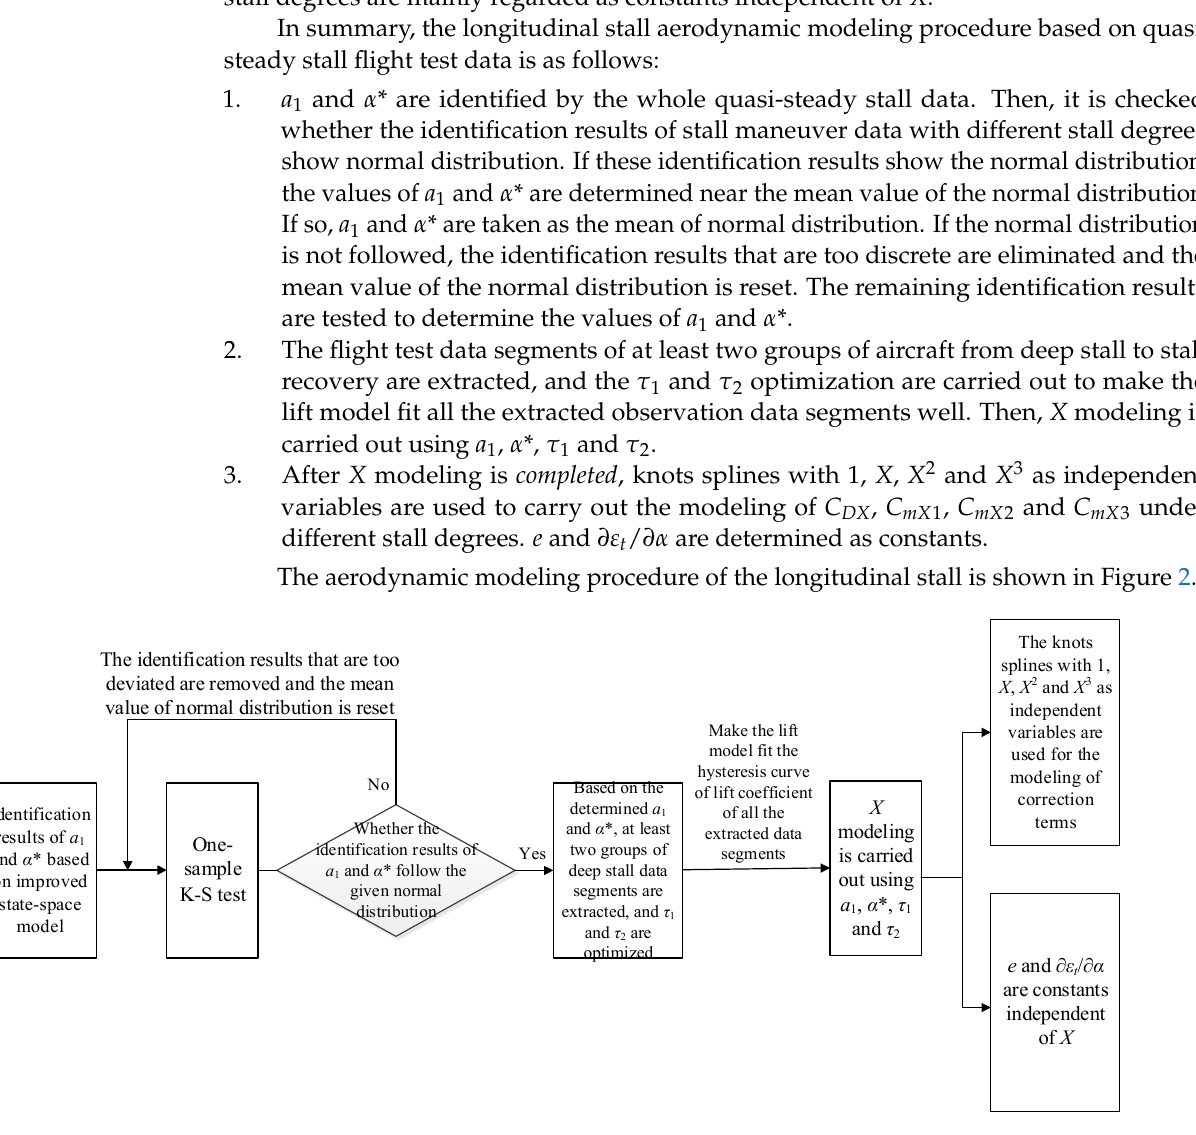
Figure 2. The modeling procedure of longitudinal stall aerodynamic of civil